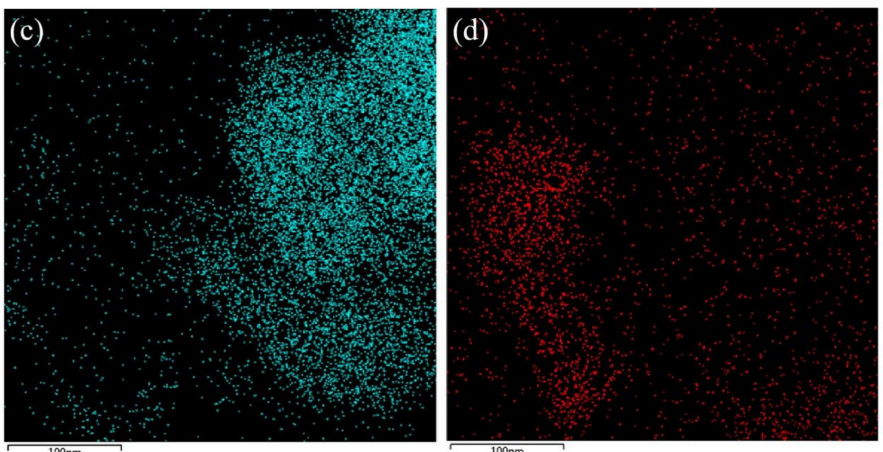
Figure 3. ( a ) The original TEM image. ( b ) Distribution of Si elements. ( c ) Distribution of O elements. ( d ) Distribution of B elements.